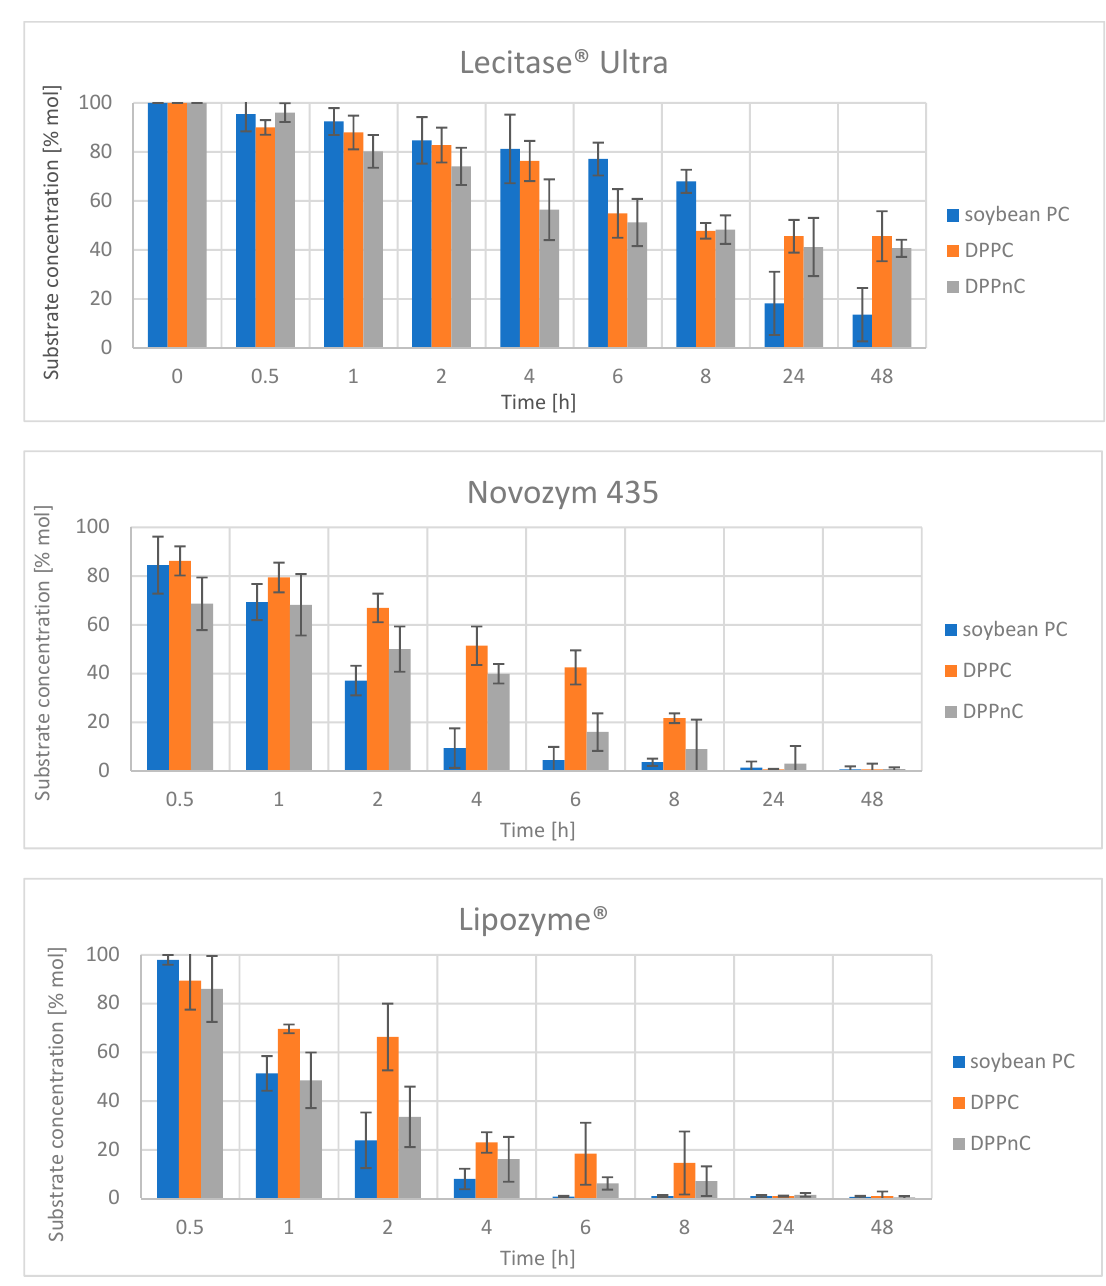
Figure 2. Enzymatic reactions of DPPnC, DPPC and soybean PC in sn ‐ 1 position. Results are presented as means ± standard deviation.